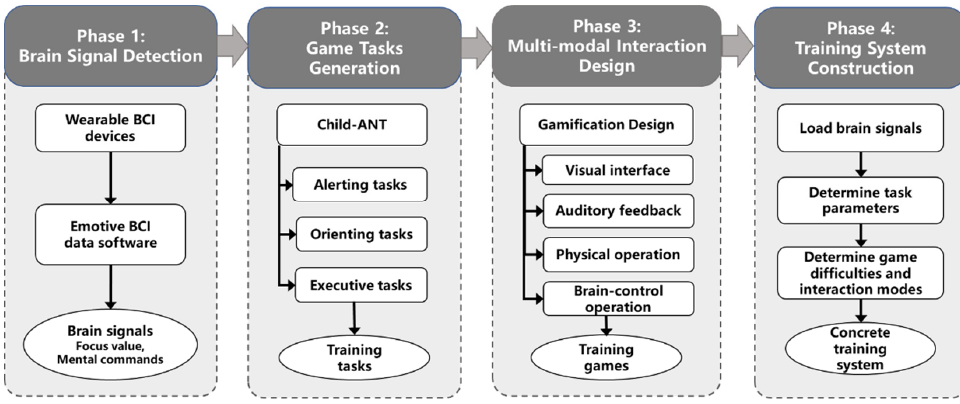
Figure 2. The detailed development procedures of the training system (authors’ proposal).